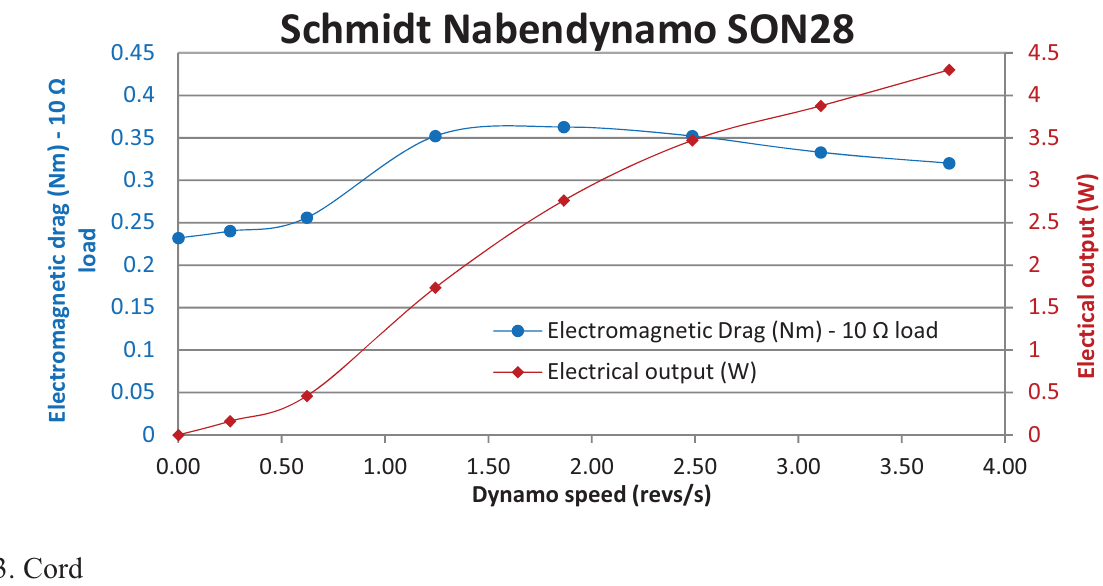
Figure 5. Characterisation of Schmidt Nabendynamo SON28, 10 (cid:3) fixed